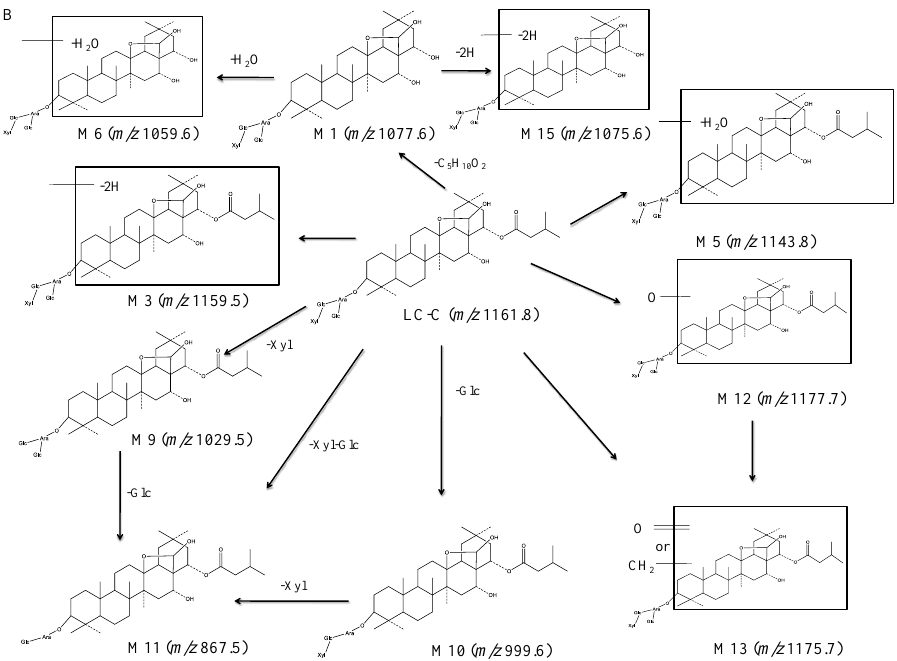
Figure 4. The proposed metabolic pathway of LC-B ( A ) and LC-C ( B ) in mice following oral dosing of total saponins of L. capillipes Hemsl extract (LCE).